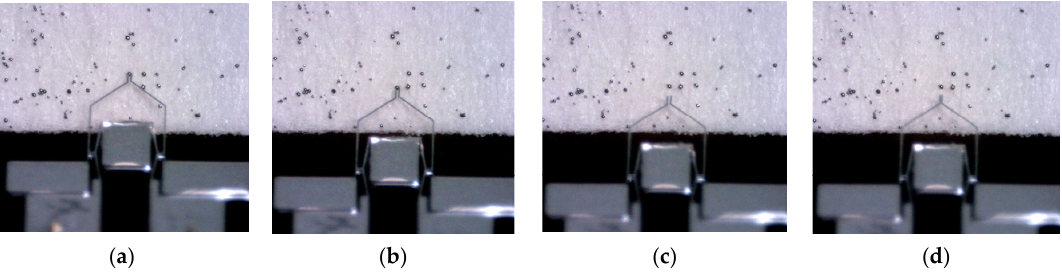
Figure 14. Micromanipulation of microbeads: ( a ) Pick a microbead from the fi rst arranged line; ( b ) Place the microbead on the second line, under the fi rst line; ( c ) Release the microbead; ( d ) Close the micro-tweezer tips.